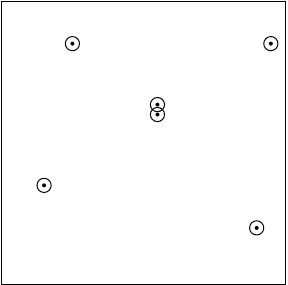
Figure 2: Sparsity is assured by penalizing closely neighboring points indicated by the overlapping disks.